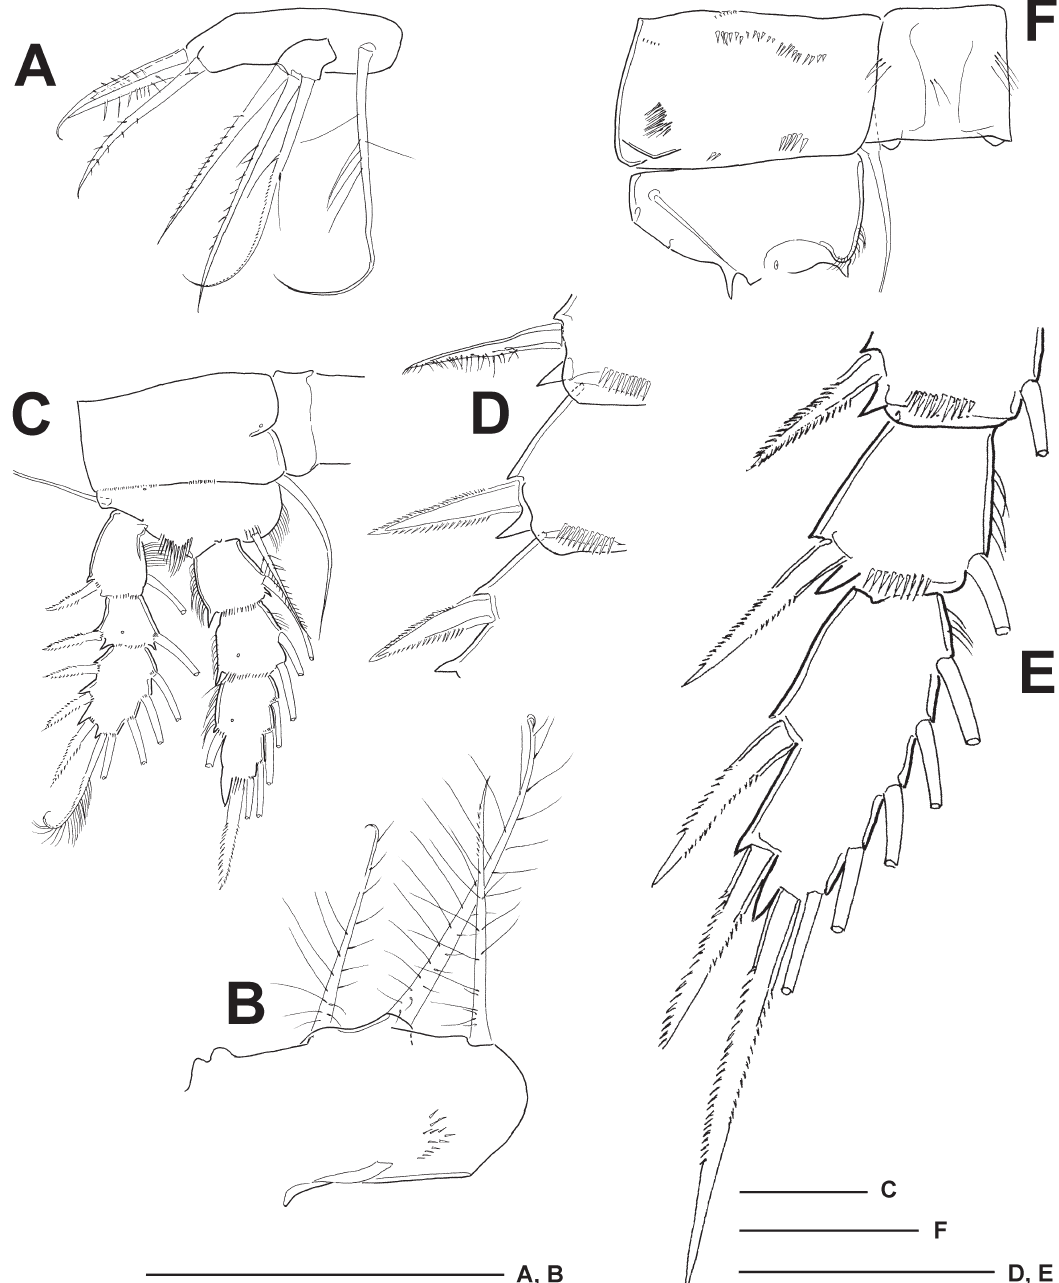
Fig. 5. Cyclops bohater koźmiński, 1933, ♂. A . maxillulary palp. B . maxilliped syncoxopodite, frontal. C . Leg 1, frontal. D . Leg 2, slender spine of first exopodal segment and robust spines of exopodal segments 2 and 3. E . exopodal armature of leg 3. F . Leg 4 coxopodite, basipodite and intercoxal sclerite, caudal. all drawings show a paralectotype (nHmUk 2016. 40). scale bars = 100